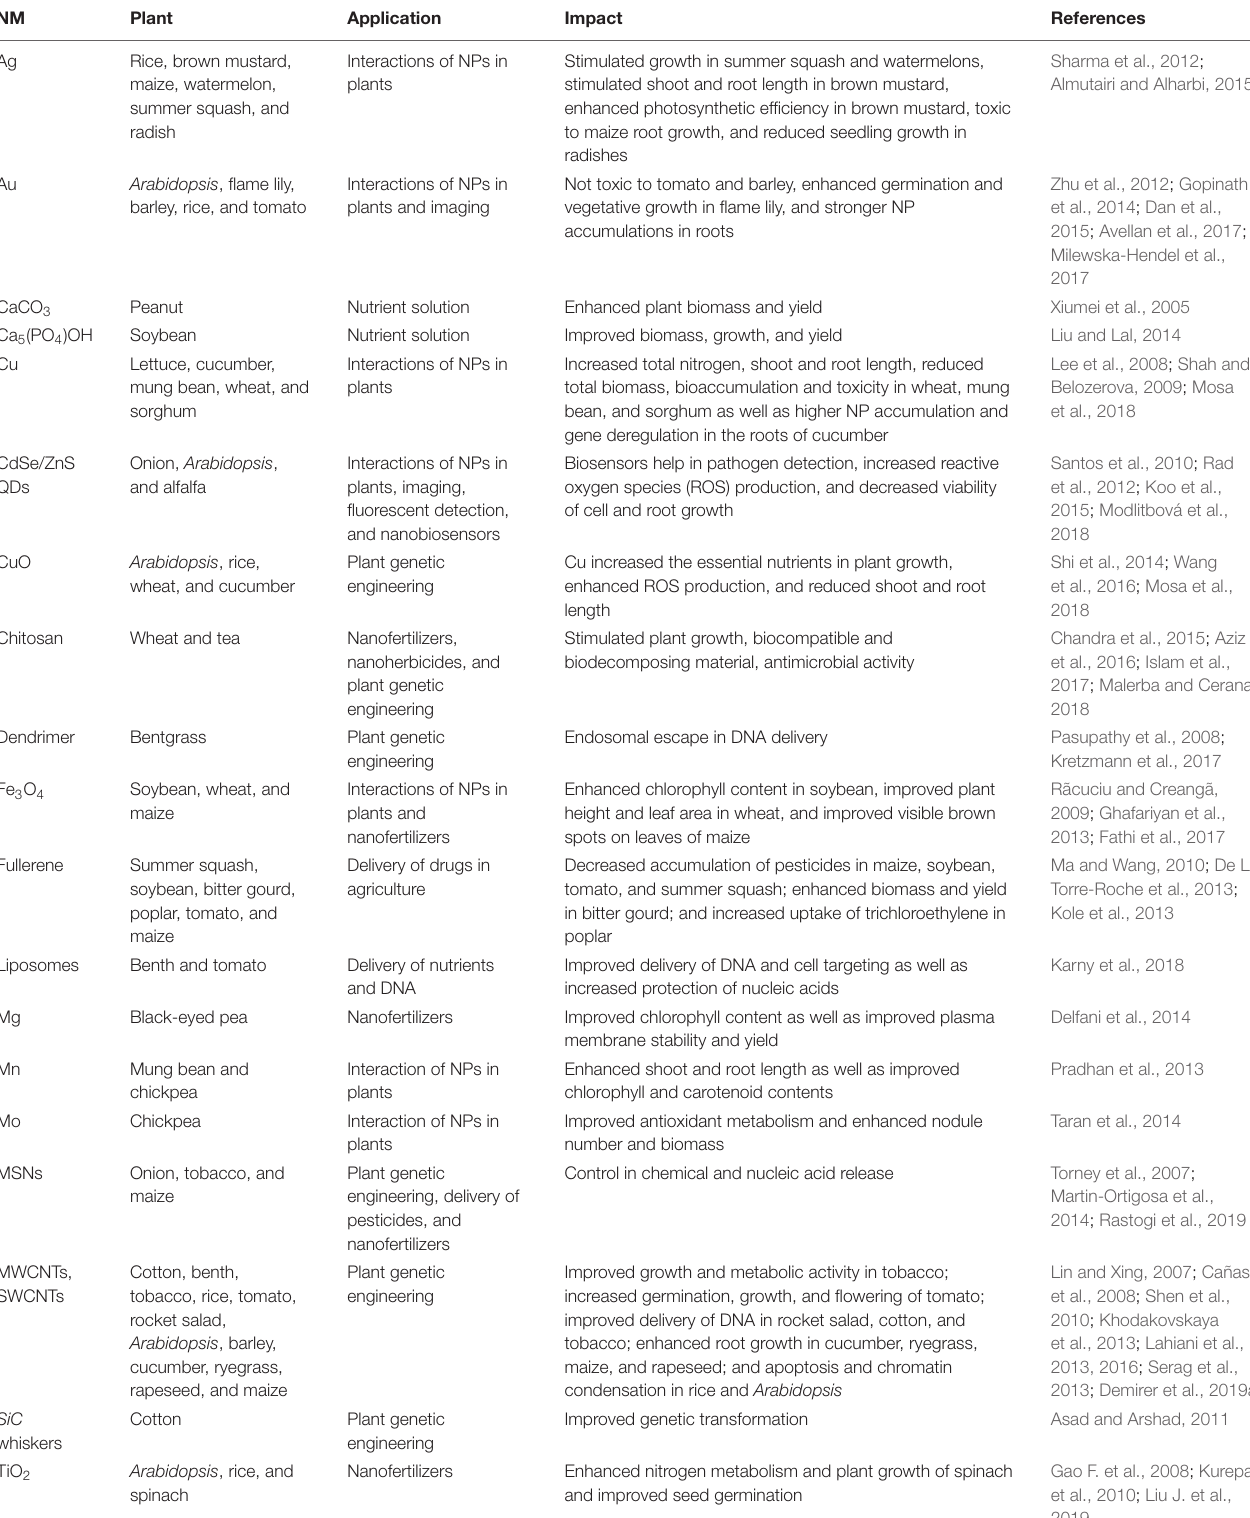
TABLE 3 | Nanomaterials (NMs) regarded as beneficial for various agricultural